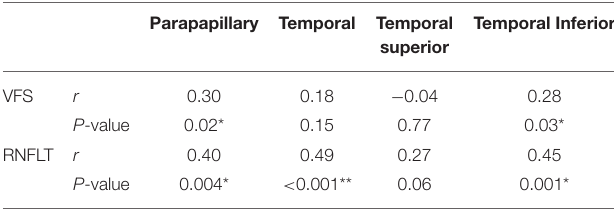
TABLE 1 | Demographics and ophthalmic characteristics of the POAG and control groups.